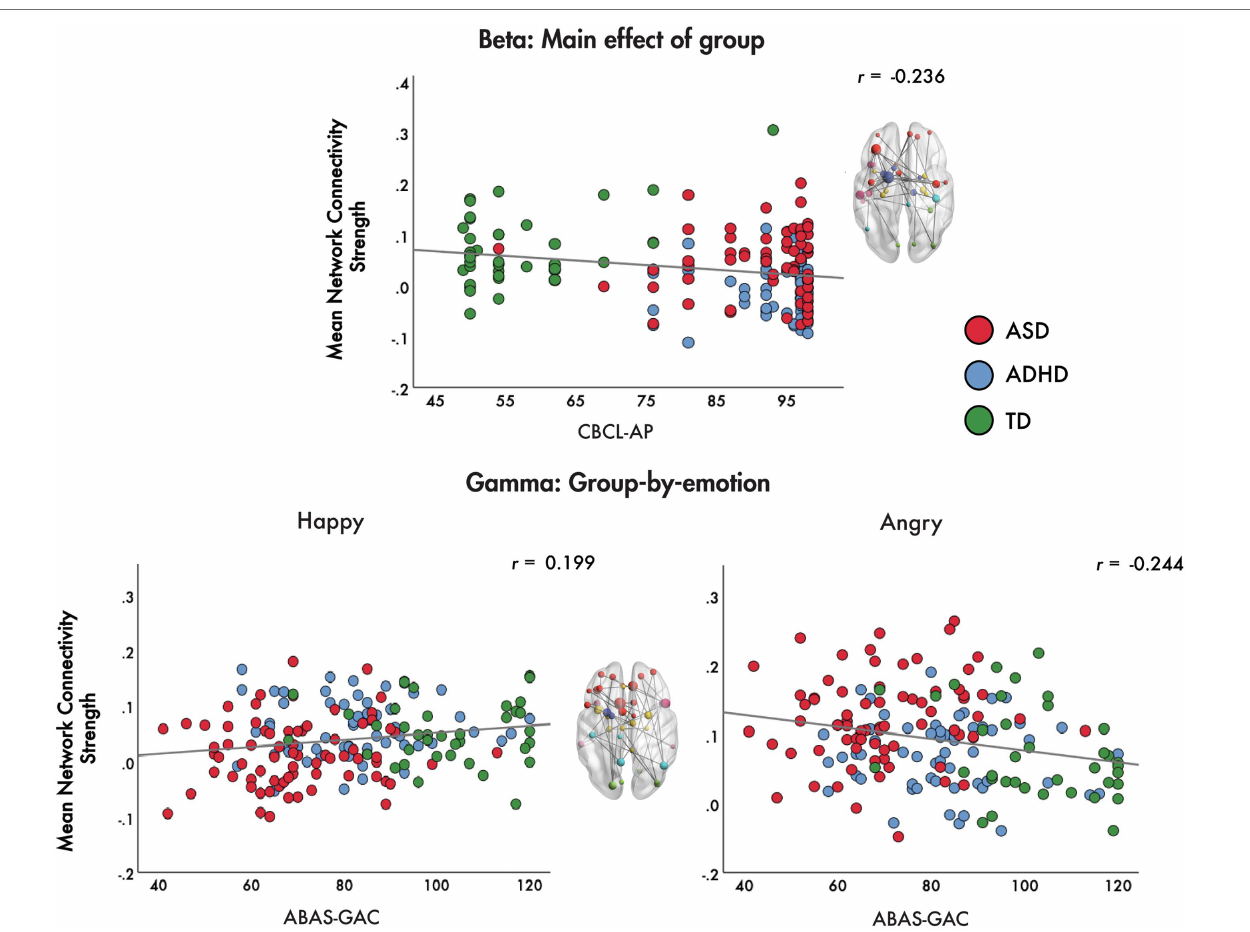
FIGURE 5 | Brain-behaviour correlations. Brain-behaviour correlations are plotted for the mean network connectivity strength for the main effect of group in the beta band and the group-by-emotion interaction in the gamma band with the CBCL-AP and ABAS-GAC,